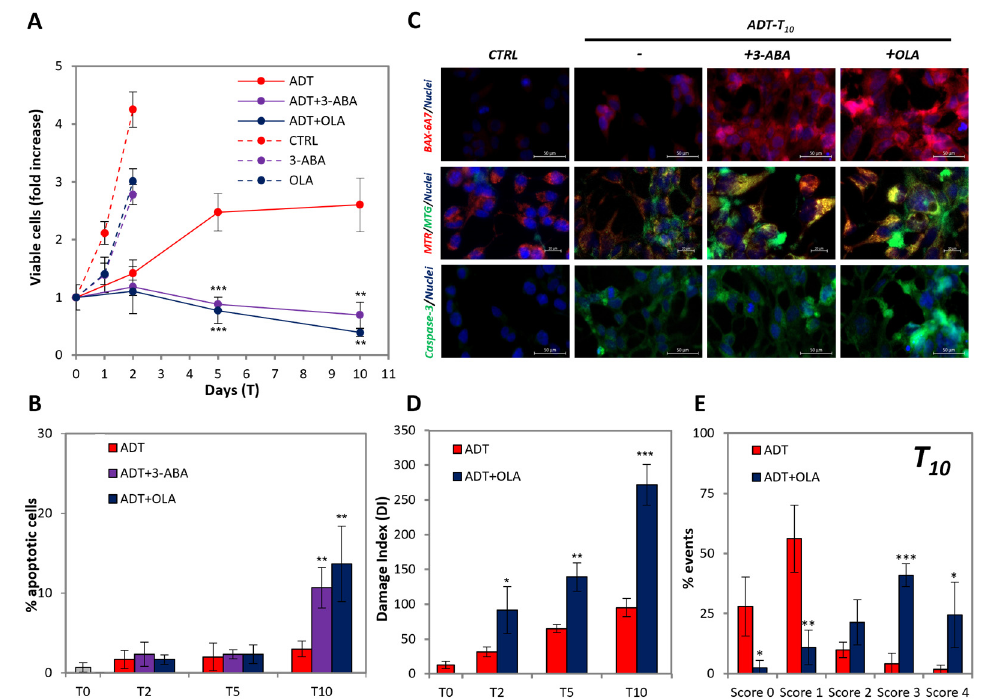
Figure 4. PARP inhibition promotes full apoptosis in ADT-treated LNCaP. ( A ) Kinetics of viable (trypan blue-excluding) cell number in ADT ± PARP inhibitors in LNCaP expressed as fold over T0. Dashed lines indicate control cells ± 3-ABA/OLA. ( B ) Extent of apoptosis in LNCaP exposed to ADT ± PARP inhibitors at the indicated time points. Statistical significance was calculated via Student’s t -test. ** p < 0.01 and *** p < 0.001, with respect to ADT-treated cells. ( C ) ADT-promoted BAX activation (top line), mitochondria permeabilization (middle line) and caspase-3 activation (bottom line) in the presence/absence of PARP inhibitors. Immunofluorescence with anti-activated-BAX (6A7) antibody (red), anti-cleaved caspase-3 (green) or live cells staining of the mitochondrial mass (MTG, green) and mitochondria with high transmembrane potential, mt ΔΨ (MTR, red). Cell nuclei are stained with Hoechst (blue). The scale bars of BAX, caspase-3 and MTG/MTR are 50, 50 and 20 µm respectively. ( D ) PARP inhibition increases ADT-induced DNA damage. Comet assay of ADT- treated LNCaP cells ± OLA: the histograms report the Damage Index at the indicated time points. ( E ) The histogram shows the scores (from 0 to 4) of DNA damage of ADT-treated LNCaP in presence/absence of OLA at the indicated time point. Statistical significance was calculated via Student’s t -test. * p < 0.05, ** p < 0.01 and *** p < 0.001, with respect to ADT-treated cells. 2.5. PARPi-Induced Apoptosis Is Caspase-Dependent We then investigated the role caspases play in PARPi-induced apoptosis. Figure 5A shows that at T10, i.e., when PARPi-induced apoptosis becomes evident, z-VAD significantly and strongly reduces apoptosis. Notably, z-VAD does not alter apoptosis induced by ADT alone, suggesting that an alternative, caspase-independent form of programmed cell death may intervene, e.g., parthanathos, which runs through the PARP- AIF-endoG axis [25]; this is coherent with the finding that at T10 z-VAD only partially reduces DNA damage (see Figure 3). Accordingly, z-VAD prevents the loss of cell viability due to PARP inhibition (Figure 5B), totally abrogating the vulnerability to PARP inhibition achieved by ADT.